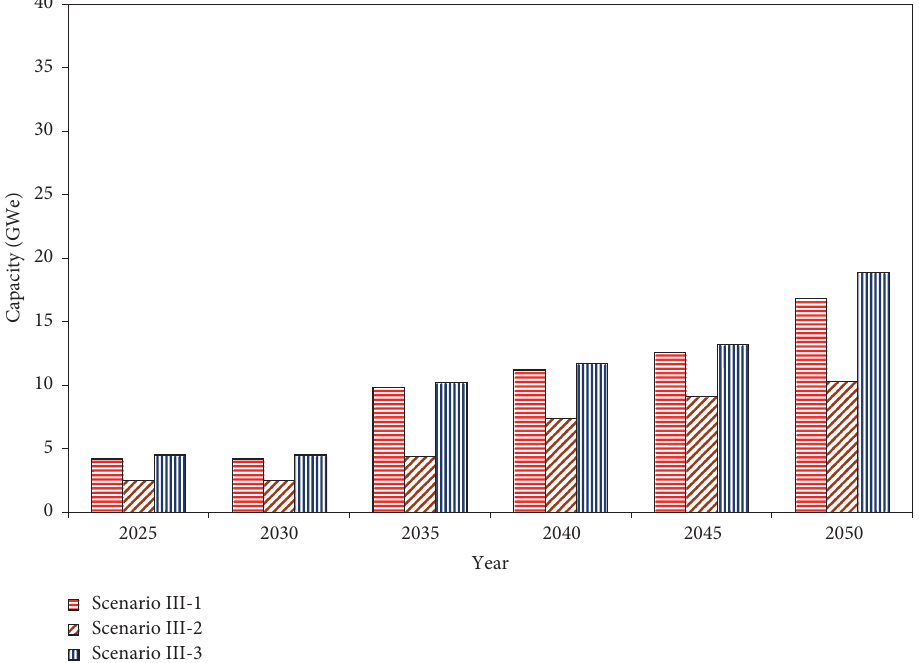
Figure 18: Installed capacity of nuclear power predicted by MESSAGE tool for Subscenarios III-1 to III-3.